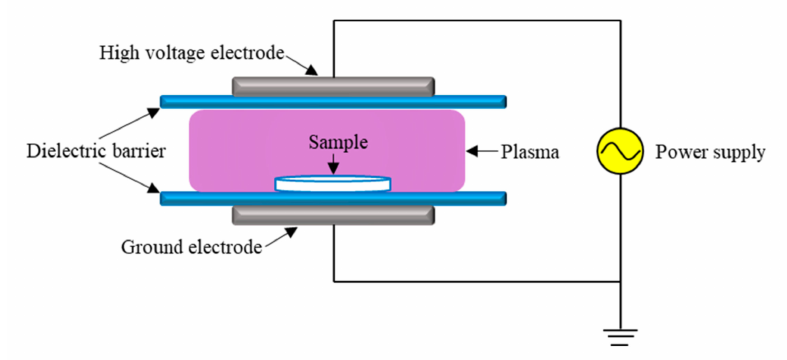
Figure 1. Schematic diagram of DBD atmospheric pressure cold